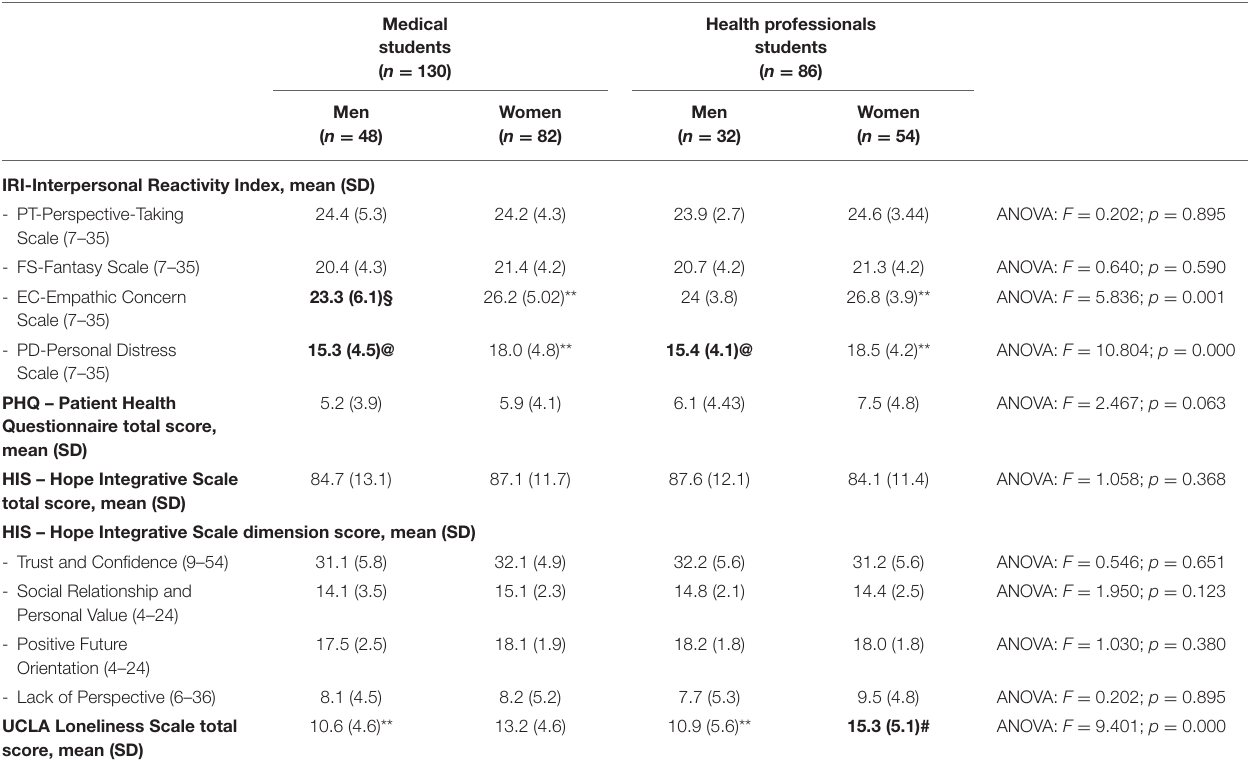
TABLE 4 | Means and standard deviations of clinical and psychological measures of total sample by gender ( n =